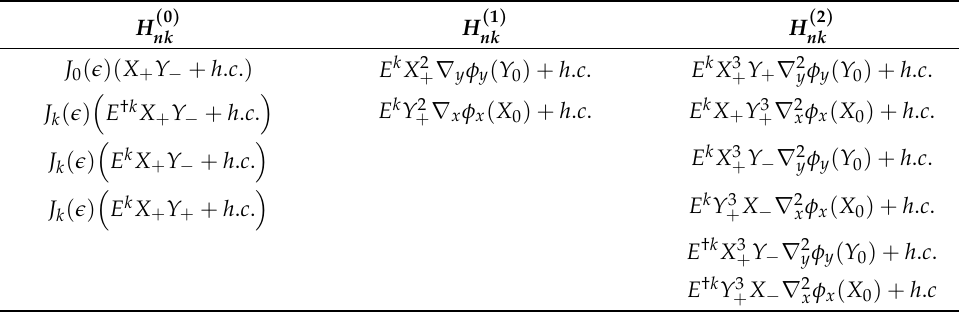
ε ( 1 ) and ε ( 2 ) for Hamiltonian (39). ∼ ∼